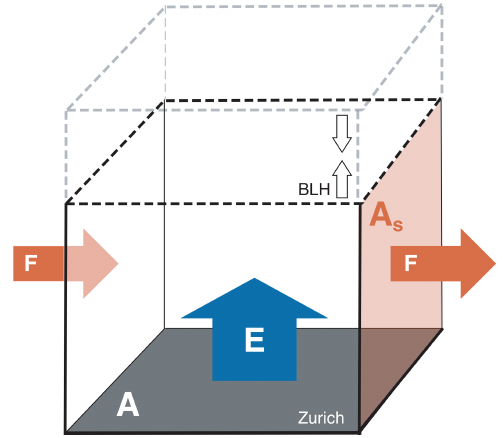
Figure 1. Box model used to estimate GEM emissions E of Zurich. A represents the area of the base and A s the area of the lateral side of the box. The variable boundary-layer height (BLH) determines the height of the box and F the advective